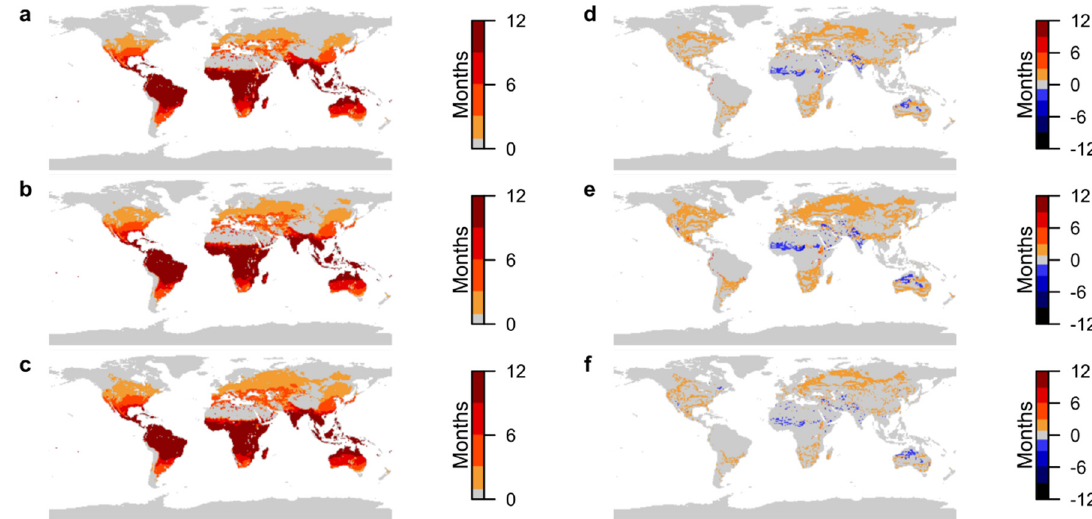
Figure 3. Projections of transmission suitability for Dengue fever. ( a ) Number of months of trans- mission suitability in present day; ( b ) number of months of transmission suitability in 2050 under SSP1-2.6; ( c ) number of months of transmission suitability in 2050 under SSP5-8.5; ( d ) change in number of months of transmission suitability from present day to 2050 under SSP1-2.6; ( e ) change in number of months of transmission suitability from present day to 2050 under SSP5-8.5; ( f ) difference in number of months of transmission suitability in 2050 between SSP5-8.5 and SSP1-2.6. For ( a – c ), colour-bar scales are set so that increasing intensity of red depicts areas where transmission suitability is marginal (1–3 months), moderate (4–6 months), seasonal (7–9 months) and endemic (10–12 months). For ( d – f ), colour-bar scales are similarly grouped, with increasing intensity of red depicting increases in transmission suitability of 1–3 months, 4–6 months, 7–9 months and 10–12 months, and increasing intensity of blue depicting the equivalent decreases. Only areas where differences are statistically significant at the 95% confidence level are